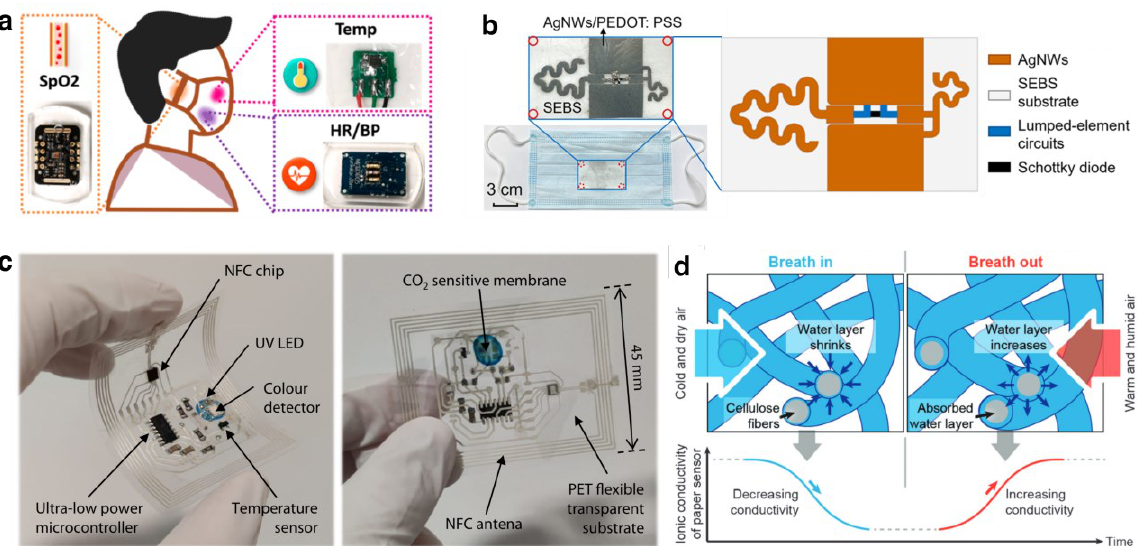
Figure 5. Mask detects macroscopic physiological signals: ( a ) A smart mask integrated with a sensor system that can remotely monitor variables like respiratory rate, heart rate, skin temperature and blood oxygen saturation (Reproduced with permission from Ref. [105]. Copyright 2020, American Chemical Society); ( b ) A self-powered mask with a sensor that detects coughs and wearing by mask deformation (Adapted and reproduced with permission from Ref. [136]. Copyright 2022, American Chemical Society); ( c ) A smart mask with CO 2 sensitive membrane that wirelessly detects CO 2 level around the wearer (Adapted and reproduced with permission from Ref. [137]. Copyright 2022, Springer Nature); ( d ) A cellulose paper-based mask that functions as a moisture sensor (Reprinted with permission from Ref. [138]. Copyright 2016, Wiley-VCH GmbH, Weinheim).